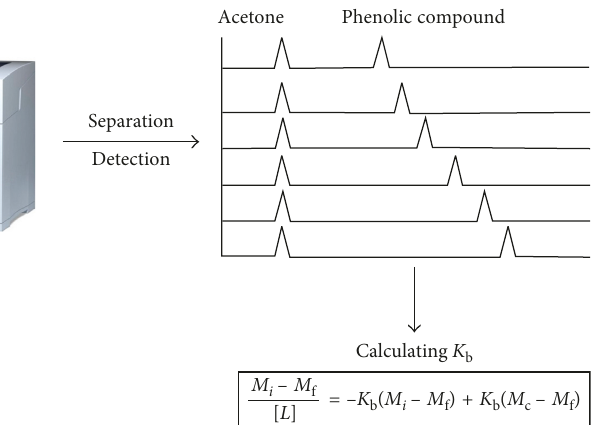
Figure 2: Schematic diagram of the steps of this study.